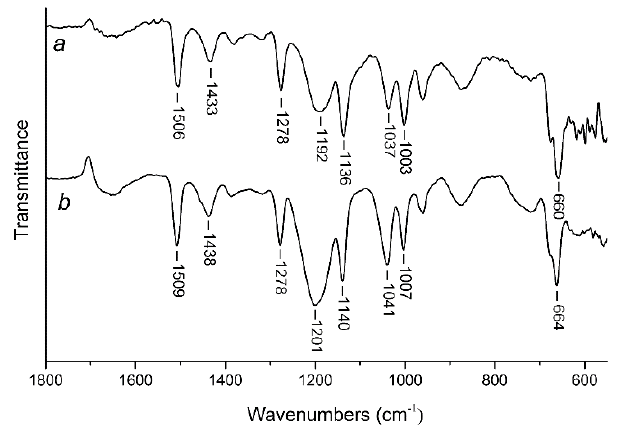
Figure 3. Fourier transform infrared spectra for the starting poly(VT-co-Na-VSA) ( a ) and AgNPs nanocomposite ( b ).